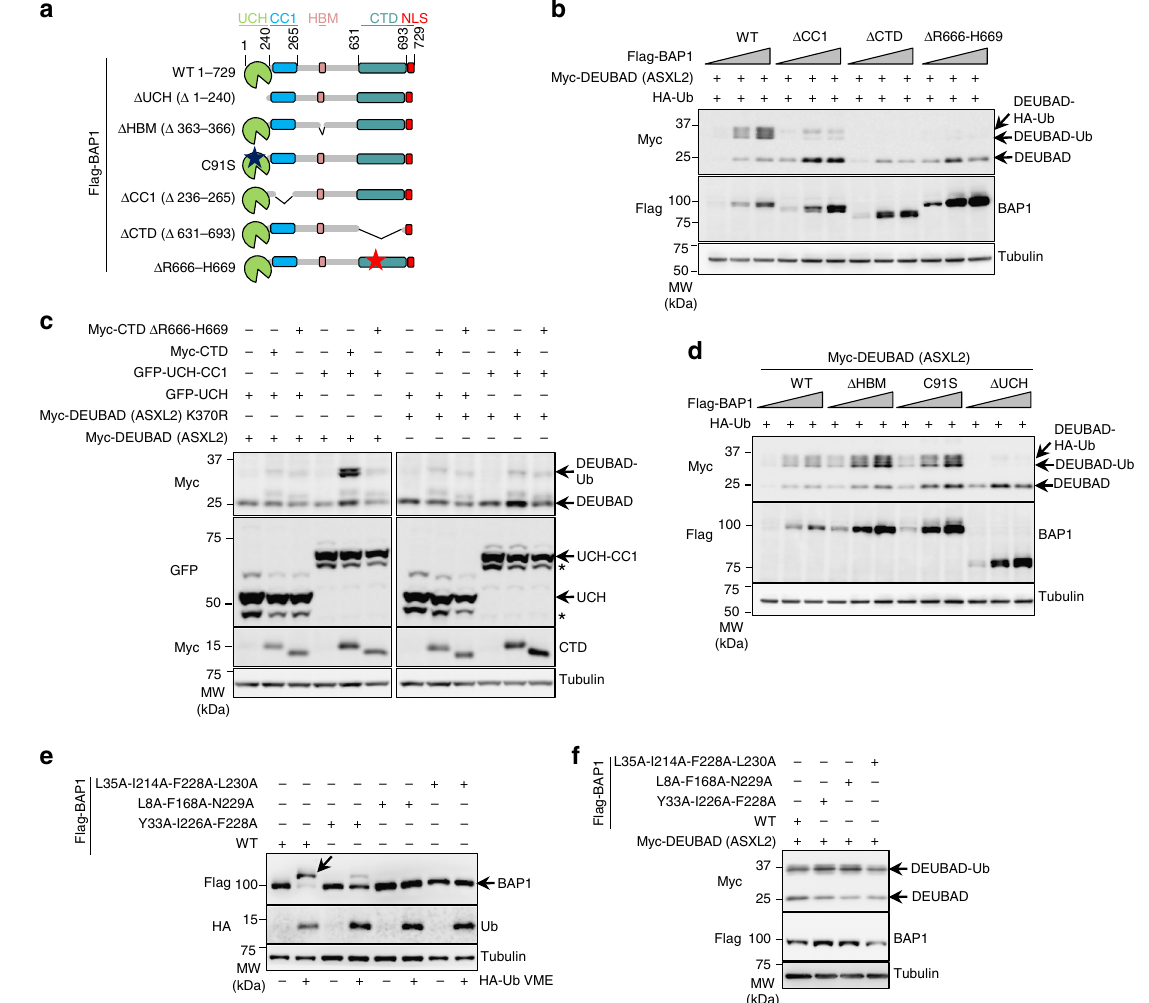
Fig. 2 Monoubiquitination of DEUBAD requires BAP1 intramolecular interactions. a Representation of the different BAP1 mutant forms used for experiments done in the panels b and d . b Disruption of the intra-molecular interactions between the catalytic (UCH) and non-catalytic (CC1 and CTD) domains of BAP1 as well as inhibition of its interaction with DEUBAD by the R666-H669 cancer associated mutation impair DEUBAD domain monoubiquitination. HEK293T cells were transfected with BAP1 and its mutant forms as indicated in presence of Myc-DEUBAD (ASXL2) and subjected to western blotting. n = 4 biological replicates. c Reconstitution of the intramolecular interactions of BAP1 promotes DEUBAD monoubiquitination. Co- transfection of Myc-DEUBAD (ASXL2) or Myc-DEUBAD (ASXL2) K370R with the corresponding GFP BAP1- or Myc-BAP1- fragments fusion constructs in HEK293T and cell extracts were used for western blotting. The star indicates a possible degradation product. The band upper UCH or UCH-CC1 represents a potential post-translational modi fi cation of this domain. n = 2 biological replicates. d Monoubiquitination of the DEUBAD domain following expression of BAP1 Δ HBM , BAP1 Δ UCH , or BAP1 catalytic dead (C91S) constructs in HEK293T cells. Increased amounts of the different Flag-BAP1 constructs were used in presence of HA-Ub and Myc-DEUBAD (ASXL2), then DEUBAD monoubiquitination was visualized by western blotting. n = 4 biological replicates. e Validation of Ub binding mutants of BAP1. Flag-BAP1 and its different mutant forms were transfected in HEK293T cells. Cell lysates were labeled with HA-Ub-VME DUB probe and analyzed by immunoblotting. n = 2 biological replicates. f BAP1 ubiquitin binding is not required for DEUBAD monoubiquitination. HEK293T cells were transfected with BAP1 Ub binding mutants in presence of Myc-DEUBAD (ASXL2) and harvested for immunoblotting. n = 2 biological replicates. Tubulin was used as a loading control for panels b –